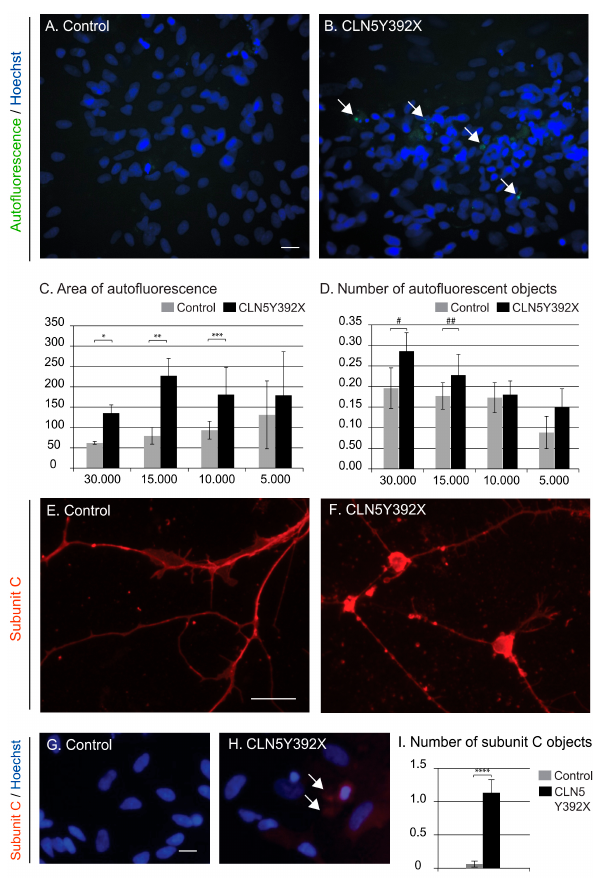
Figure 4. Intracellular storage accumulation in iPSC-derived neural lineage cells. Appearance of storage material within cells analysed by measuring the amount of autofluorescence ( A – D ) and subunit C staining ( E – I ). Representative images showing autofluorescent compartments (green) and nuclei (Hoechst 33258, blue) in control ( A ) and CLN5Y392XiPSC-derived neural lineage cells ( B ) viewed using a high-content microscope; Quantitative image analysis shows the average area of autofluorescent compartments ( C ) as well as the average number of autofluorescent objects ( D ) in control (grey bars) and CLN5-deficient (black bars) cells (arbitrary units). The x axis indicates the plated cell number per 96-well ( C , D ). Each column in C and D represents the average value of four replicates per condition each normalised to the number of cells analysed in the replicate (average of 1379 cells per replicate); Representative images of control ( E ) and CLN5Y392XiPSC-derived neural lineage cells ( F ) stained with a polyclonal antibody against subunit C of the mitochondrial ATP synthase (red) and viewed using a traditional epifluorescence microscope; High-content immunofluorescence microscopy images of subunit C staining in control ( G ) and CLN5Y392X neural lineage cells ( H ); Results from the quantitative image analysis showing the average number of subunit C positive objects in control (grey bars) and CLN5-deficient cells (black bars) ( I ). Both columns in I represent the average value of 2–3 replicates each normalised to the number of cells analysed in the replicate (average of 587 cells per replicate). All error bars in the figure represent standard deviations (stdev). White arrows indicate the presence of autofluorescent/stained storage material. Bar 20 µm. p -values, 0.0024 (*), 0.0004 (**), 0.0371 (***), 0.018 (#), 0.0708 (##) and 0.0027 (****) (one-tailed Student’s t test).